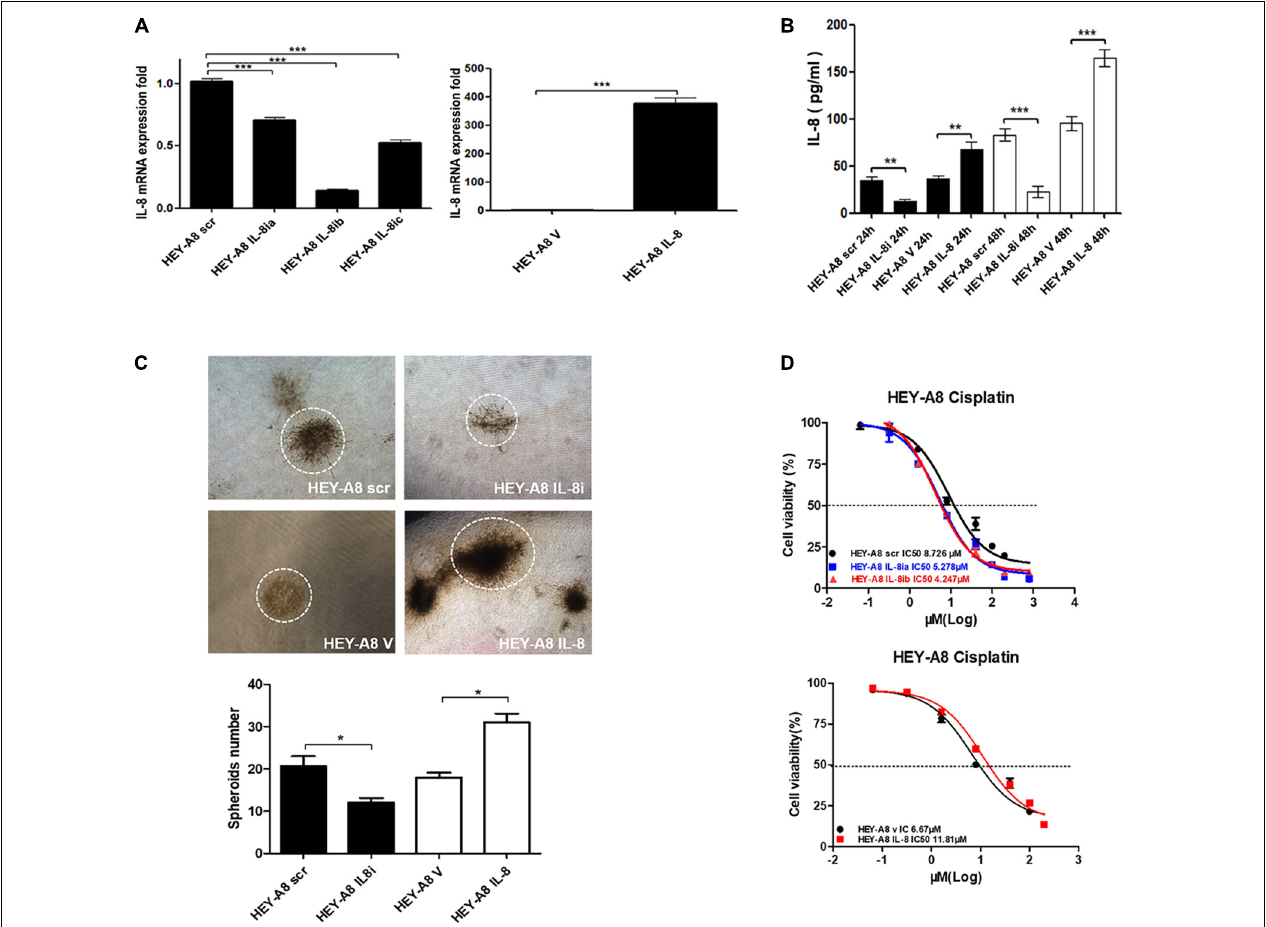
FIGURE 4 | IL-8 enhances ovarian cancer cell stemness and chemoresistance. (A) Examination of IL-8 expression in IL-8 overexpression and silencing ovarian cancer cells by qRT-PCR. (B) Measurement of IL-8 secreted from overexpression and silencing cells by ELISA. (C) Spheroids formed by IL-8 overexpression and silencing ovarian cancer cells in 3-D culture. (D) Survival rates of ovarian cancer cells expressing IL-8 shRNA or cDNA tested by CCK-8 following the treatment with cisplatin. OD values were measured after treatment with cisplatin at 48 h. * p < 0.05, ** p < 0.01, *** p < 0.001. IL, interleukin; CCK-8, Cell Counting Kit-8; OD, optical